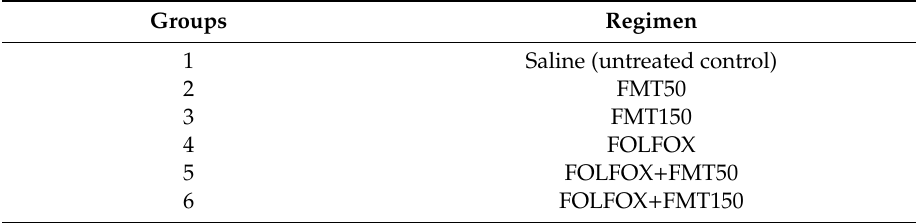
Table 1. Colorectal cancer-bearing mice ( n = 10 in each group) groups in which the e ff ects of fecal microbiota transplant (FMT) on FOLFOX-induced intestinal mucositis were evaluated. Groups